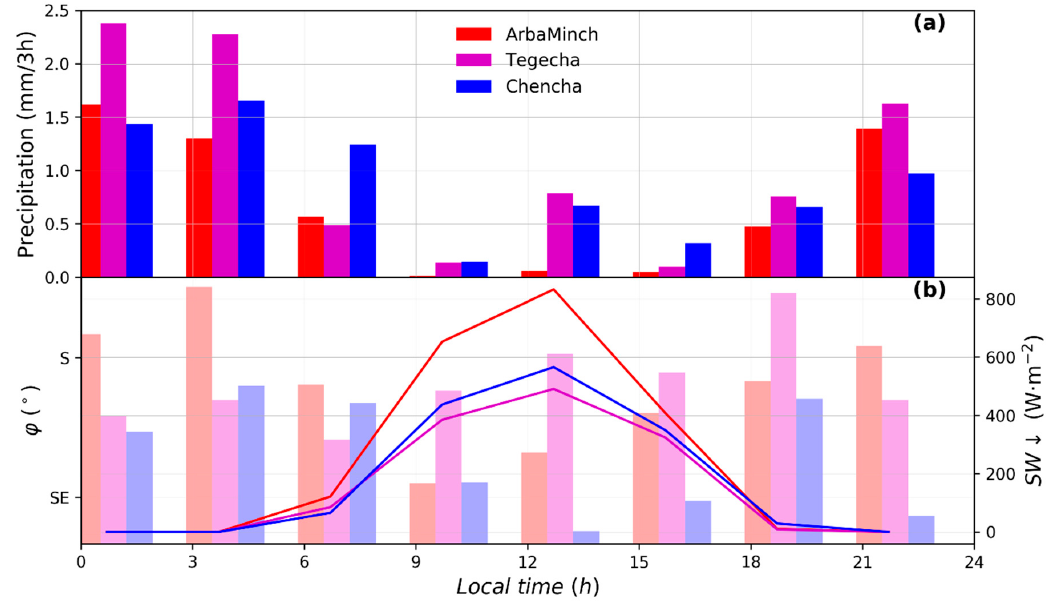
Figure 8. ( a ) 3-h total precipitation (mm/3 h), ( b ) 3-h mean ϕ (°) (bar plots) and SW ↓ (W ∙ m − 2 ) (line plots). Data from Arba Minch, Tegecha, and Chencha GEMS network in the SN transect in May.